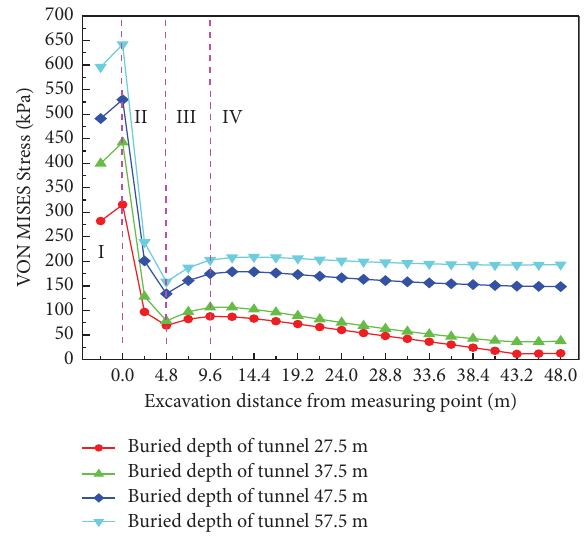
Figure 8: Curve of Von Mises stress in tunnel vault’s surrounding rocks with the advancing tunnel face under diferent buried depth.